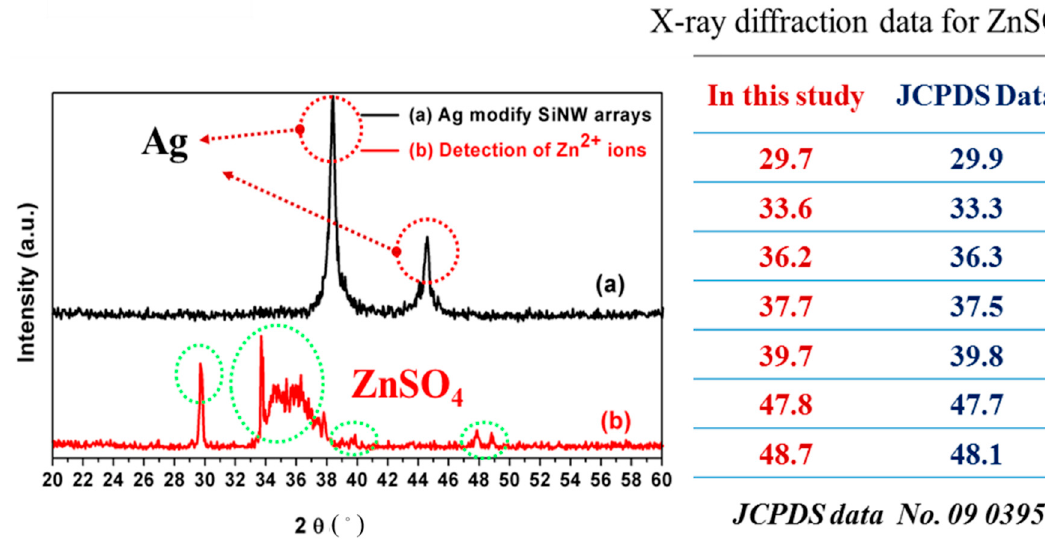
Figure 6. Comparison of X-ray diffraction spectra of ( a ) the Ag–SiNW arrays and ( b ) the Ag–SiNW arrays immobilized with BSA and ZnSO 4 for the detection of Zn 2+ ions.